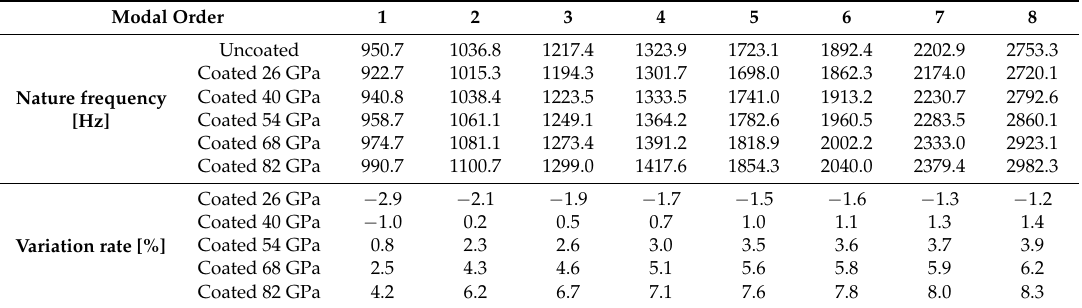
Table 6. The influence of elastic modulus of hard coating on the natural frequency of the composite shell.